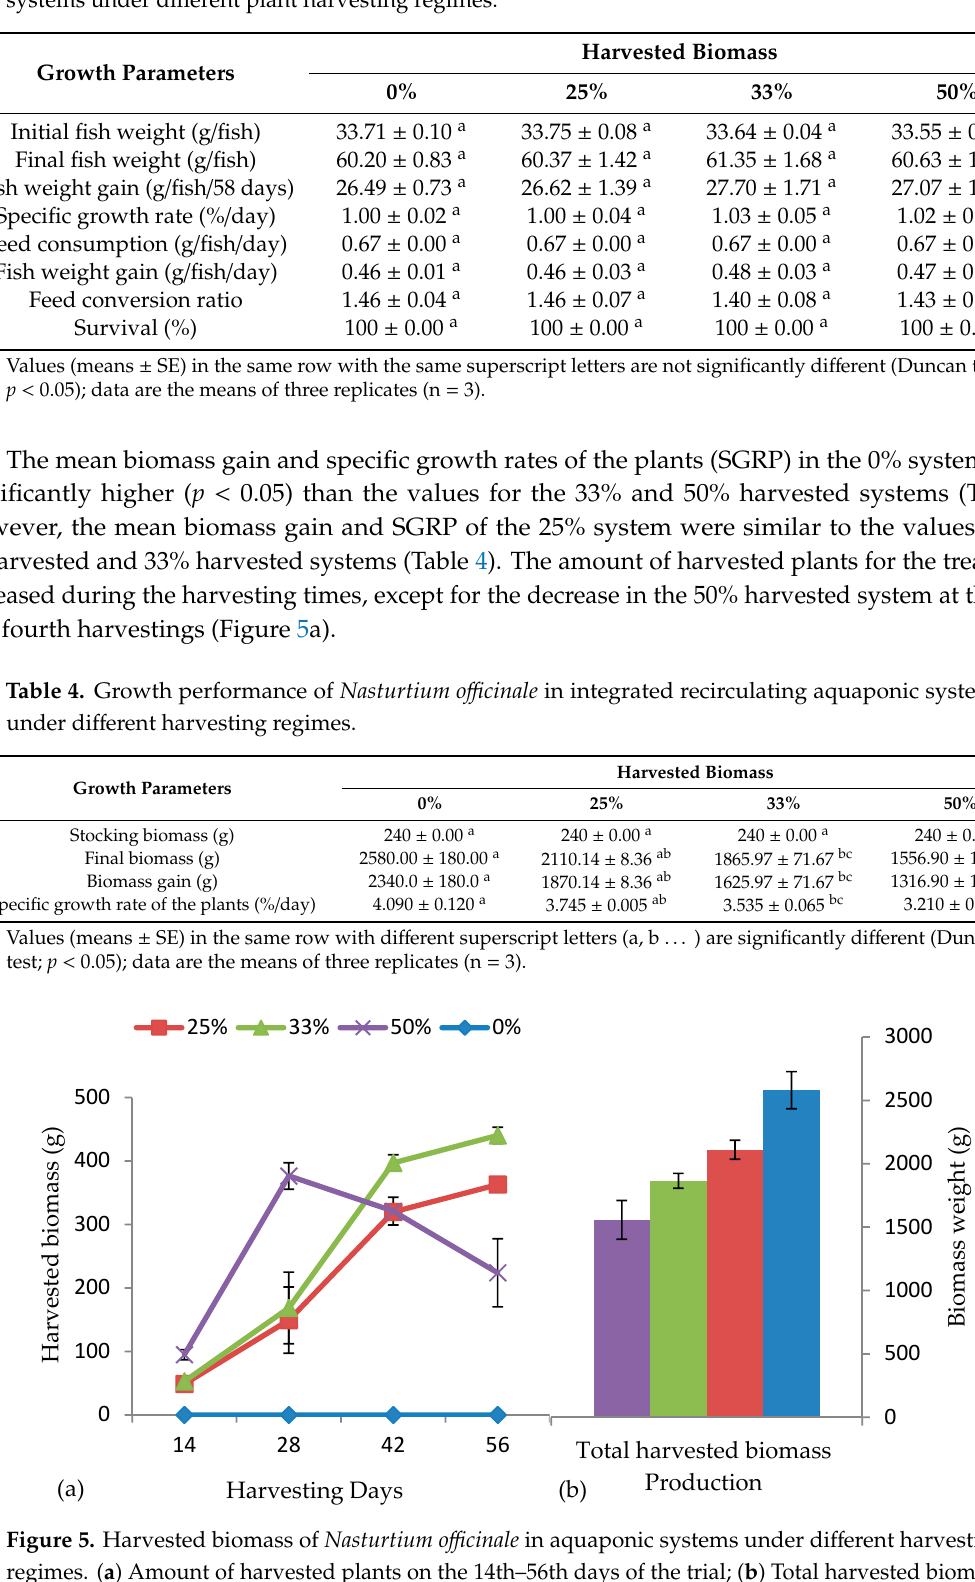
Figure 5. Harvested biomass of Nasturtium officinale in aquaponic systems under different harvesting regimes. ( a ) Amount of harvested plants on the 14th–56th days of the trial; ( b ) Total harvested biomass production in each treatment (data are the means of three replicates (n = 3), and error bars indicate the standard errors). Table 4. Growth performance of Nasturtium officinale in integrated recirculating aquaponic systems under different harvesting regimes. Growth Parameters